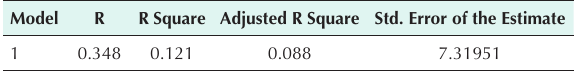
Table 2. Summary of the Regression Model Model